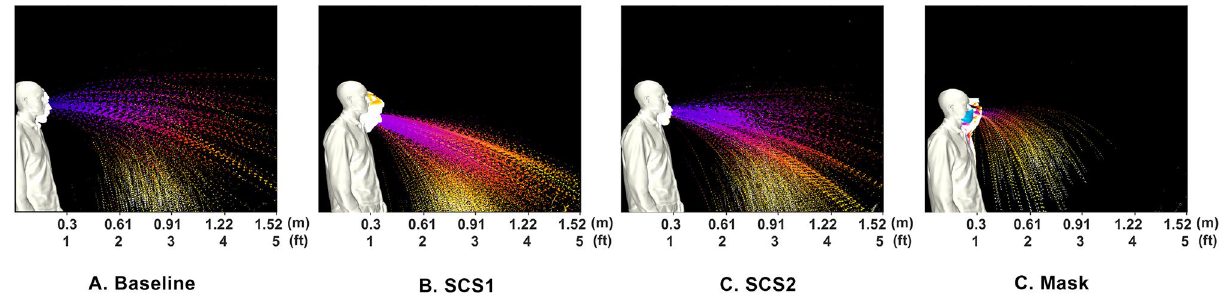
Figure 2. Summary of droplet exposure from Human Sneeze with various modifiers. Cases compare ( a ) baseline saliva, ( b ) SCS1, ( c ) SCS2, and ( d ) distance, which enables secondary dispersion mechanisms (such as room currents and/or winds) to more safely dilute the aerosols. Such a result is useful for comparison to present mitigation methods. In order to improve the understanding, the images are processed such that they separate droplets and aero- sols. A time-lapse of the droplets is depicted in Fig. 2 where the time-lapse image represents the overall spatio- temporal droplet exposure in a single image. Here, the droplets are extracted from each image and stacked and colored by time (purple is near 0 s and white is 0.5 s). These interpretations indicate the overall region that is exposed to droplets throughout the entire duration of the event. These time lapses are performed for droplets in Figs. 2 and 7. Additionally, a similar time lapse of the aerosols are presented in the left subpanel of Figs. 3 and 6. The spatio-temporal exposure to aerosols is presented in figure Fig. 3. This provides the spatio-temporal exposure to aerosols through the event using a similar time lapse applied to the aerosols (first column) along with a distance dependent exposure map (DDEM) in columns 2–4. Expanding on the evaluation of the DDEM in Fig. 3, these plots qualitatively evaluate aerosols. The plots are based on image intensities from the processed images that focus on aerosols. They are normalized by the peak intensity to provide a qualitative metric referred to as an “Exposure”. These exposures are plotted as a function of vertical space (y-axis) and time (x-axis). These are plotted at various axial distances to provide an assessment of the exposure at distance from a sneeze. These over- all assessments are used to qualitatively assess exposure from the human sneeze. In this figure, each sub-figure (row) corresponds to the various test cases, e.g., baseline, SCS 1 and 2, and mask. While each of the columns depict various measure of potential exposure levels to the aerosols. In evaluating the time-lapse of the aerosols (column 1), the results indicate the overall region and intensity of exposure to aerosols. The DDEM helps to add a temporal aspect. DDEMS are created using vertical intensity profiles at a given horizontal distance from the sneeze through time. The result is an aerosol exposure potential (color) as a function of height (vertical axis) versus time (horizontal axis). These DDEMs are generated at 0.610 m (2 ft), 0.914 m (3 ft), and 1.220 m (4 ft), in columns 2, 3, and 4, respectively. Note that the baseline condition is overlaid in grey scale for reference. These figures are used to approximately quantify the bulk exposure of aerosols from a human sneeze. The results from Fig. 3 indicate that the bulk fluid properties in one’s saliva directly correlate to the character of the droplets and aerosols expelled from a sneeze. In general, in comparing Fig. 3A–C, the content of aerosols appears to be reduced. In evaluating the droplets, in Fig. 2, at increased distances there is a clear rise in the amount of droplets. The SCS droplets appear to have a steeper downward trajectory that can be associated with an increased droplet size. Interestingly, the mask also displays droplets (which was an unexpected, yet repeat- able, observation). It is believed that this is a result of coalescence within the mask that forms with the extreme respiratory event. In general, the processed imagery suggests that the SCS leads to more droplets that tend to be larger and appears to deplete the aerosol content. Such an effect is consistent with reducing fluid-dynamic breakup mechanisms. In order to better understand this effect, this character is evaluated using computational fluid dynamics (CFD) in the context of Lagrangian droplets in a thermally buoyant sneeze event as described in “Numerical methods” section below. The numerical simulations included evaporation model that accounts for mass transfer between liquid droplets and the surrounding air. Results are provided in Fig. 4, where the properties of the three saliva types are changed in similar directions as the experiments, i.e., from thinning to thickening the saliva. Such a sensitivity study is used to understand the underlying physical mechanisms. Results are plotted in terms of the dispersed droplets 5 s after the sneeze for (a) baseline saliva, (b) SCS1, and (c) AC saliva (discussed in following section). The droplet size distributions, and the corresponding locations, are highlighted by color. Similar to the experiments, the CFD clearly indicates trends similar to a modification towards larger droplets. Hence, the SCS experiments indicate character similar to having larger droplets that tend to fall from the sneeze plume. Alternatively, a thinner saliva results in smaller droplets that remain suspended with the sneeze plume. Hence, the resulting droplet size distributions shows in a very controlled numerical model to completely alter the saliva content in a plume. Effect of saliva content. The second series of studies explores the effect of droplet dispersion from a human sneeze resulting from factors that increase or decrease the saliva content. Essentially, it is hypothesized that the exhaled droplets and aerosols are directly correlated to the amount of saliva in ones mouth. In this approach, we studied these effects by stimulating the salivary glands (SS) using a sugar-based lozenge (or cough drop). To reduce the amount of saliva, an anticholinergic (AC) was explored that is based on Zingiber officinale.